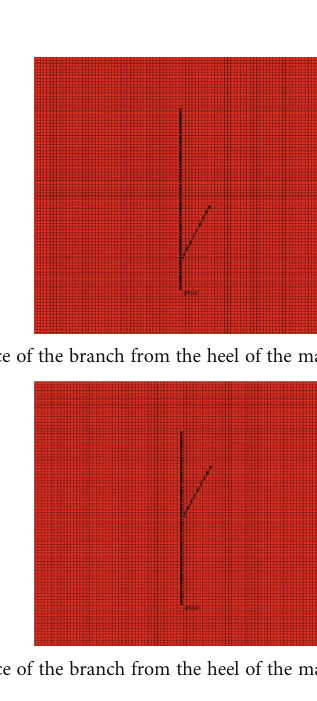
Figure 17: CMG model establishment with di ff erent branch